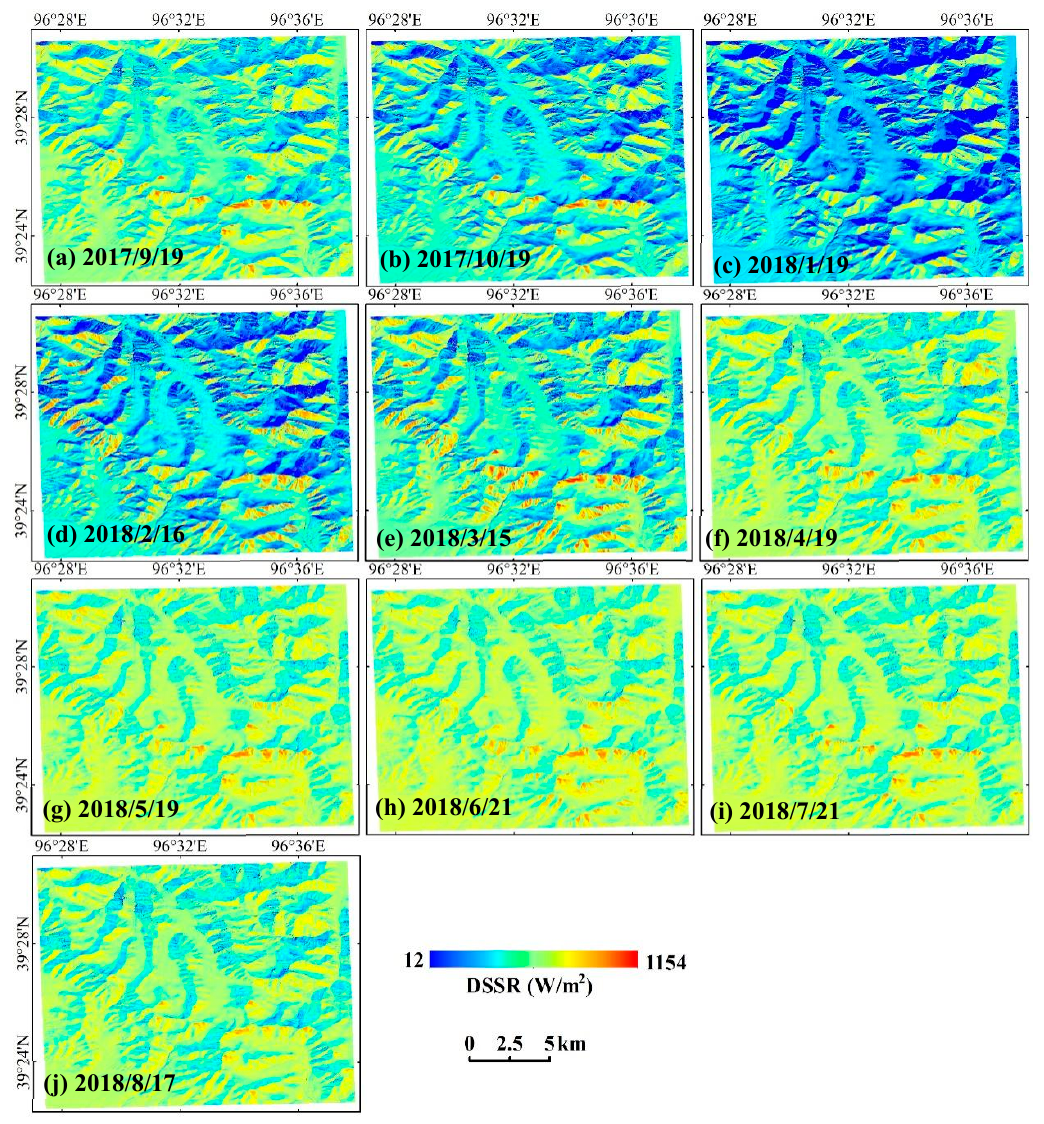
Figure 8. Spatial distribution of the daily average DSSR over ten typical periods during a mass-balance year from September 2017 to August 2018. To quantify the spatiotemporal variation for the daily average DSSR in complex terrain areas, five representative topographic locations, i.e., P1, P2, P3, P4, P5 and the regional average (averaged DSSR over the whole domain) for analysis. Among them, P2 and P4 are located in relatively flat areas at different elevations, as shown in Figure 9a. Point P1 is located on the 52 ◦ slope of the south, point P3 is located on the 39 ◦ slope of the northeast slope, and point P5 lies on a 46 ◦ slope in the north. Figure 9b depicts the variation curves of the daily average solar irradiance at the five points and the regional average DSSR. It is easy to see that the DSSR seasonal variation is similar to the regional average (sinusoidal) at the two points on the flat glacier surface. The solar irradiance at P3 and P5 on the north and northeast slopes was low throughout the year, even the DSSR value is close to zero from November to January of the next year. However, the solar radiation at point P1 is very high during the same period, even exceeding the solar constant (1367 ± 7 W/m 2 ), which is caused by two main reasons: one is that the cosine of the solar illumination angle at the southern slope is always very high; the other is that the surrounding-reflected radiation at P1 is extremely strong because the surrounding surface is covered with snow of ice